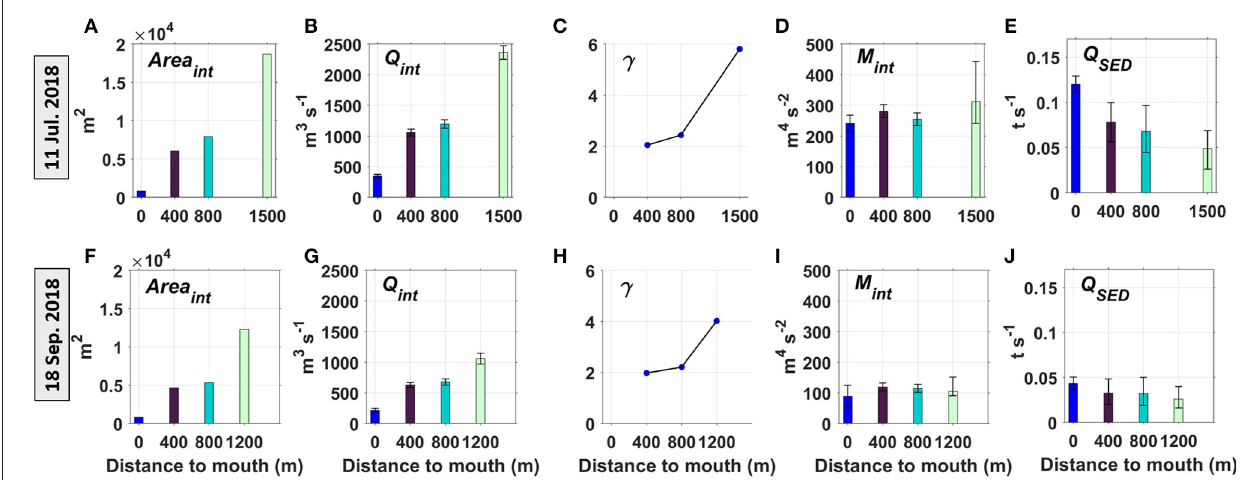
FIGURE 10 | (A,F) Interflow area Area int (m 2 ), (B,G) water discharge Q int (m 3 s − 1 ), (C,H) entrainment γ , (D,I) momentum flux M int (m 4 s − 2 ), and (E,J) suspended sediment discharge Q SED (t s − 1 ) of the interflow computed at 400m (corresponding to T1 transects), at 800m (T2 transects), at 1,200m (T3-a transect), at 1,500m (T3-b transect) from the mouth, and for the whole river section at Porte du Scex (at 0m). The error bars on (B,D,G,I) represent the standard deviations. The error bars on (E,J) are explained in the Supplementary Material . Top panels: for 11 July 2018; Bottom panels: for 18 September